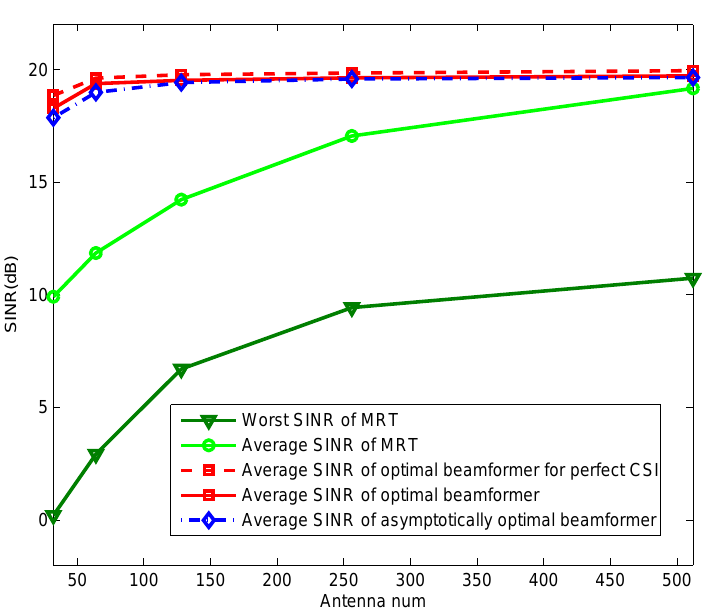
Figure 7. The achieved SINR among several algorithms with regard to M ( I = 4, K = 3, τ = 0.1, P = 46